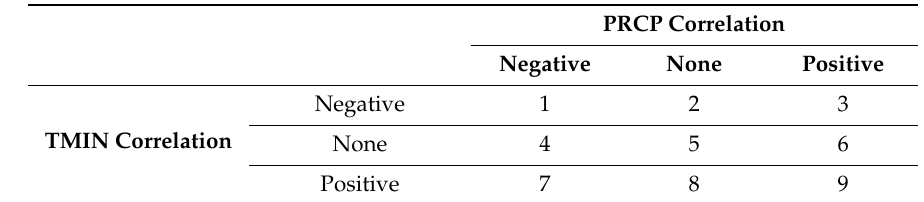
Table 1. Correlation zones were generated for each cover type. These zones were used as a sub-stratum in the model nested within each management unit. Historical transitions were adjusted in the Representative Concentration Pathway (RCP) 8.5 scenario for each zone based on the di ff erence between reference and projected RCP 8.5